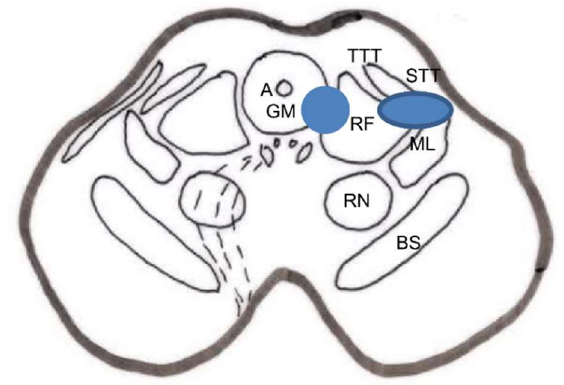
Figure 13. Two types of lesions proposed for stereotactic mesencephalotomy: medial or extralem-